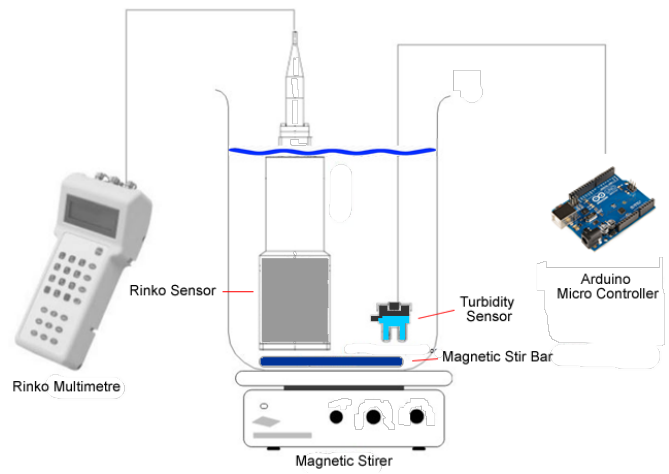
Figure 6. Turbidity Calibration Setup.